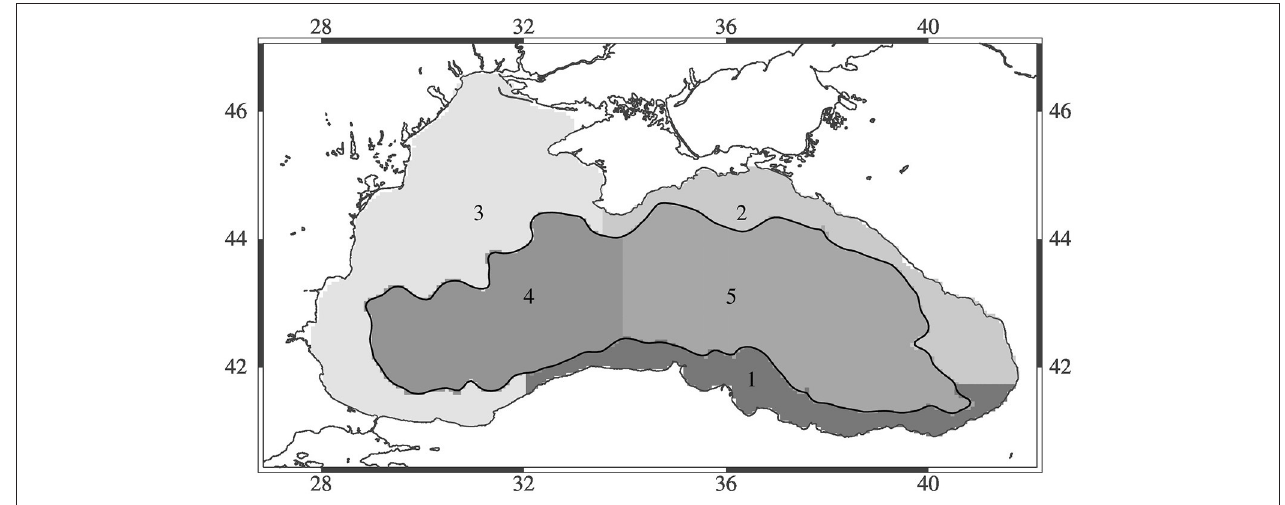
FIGURE 3 | Map of the Black Sea showing the five different regions assessed in this